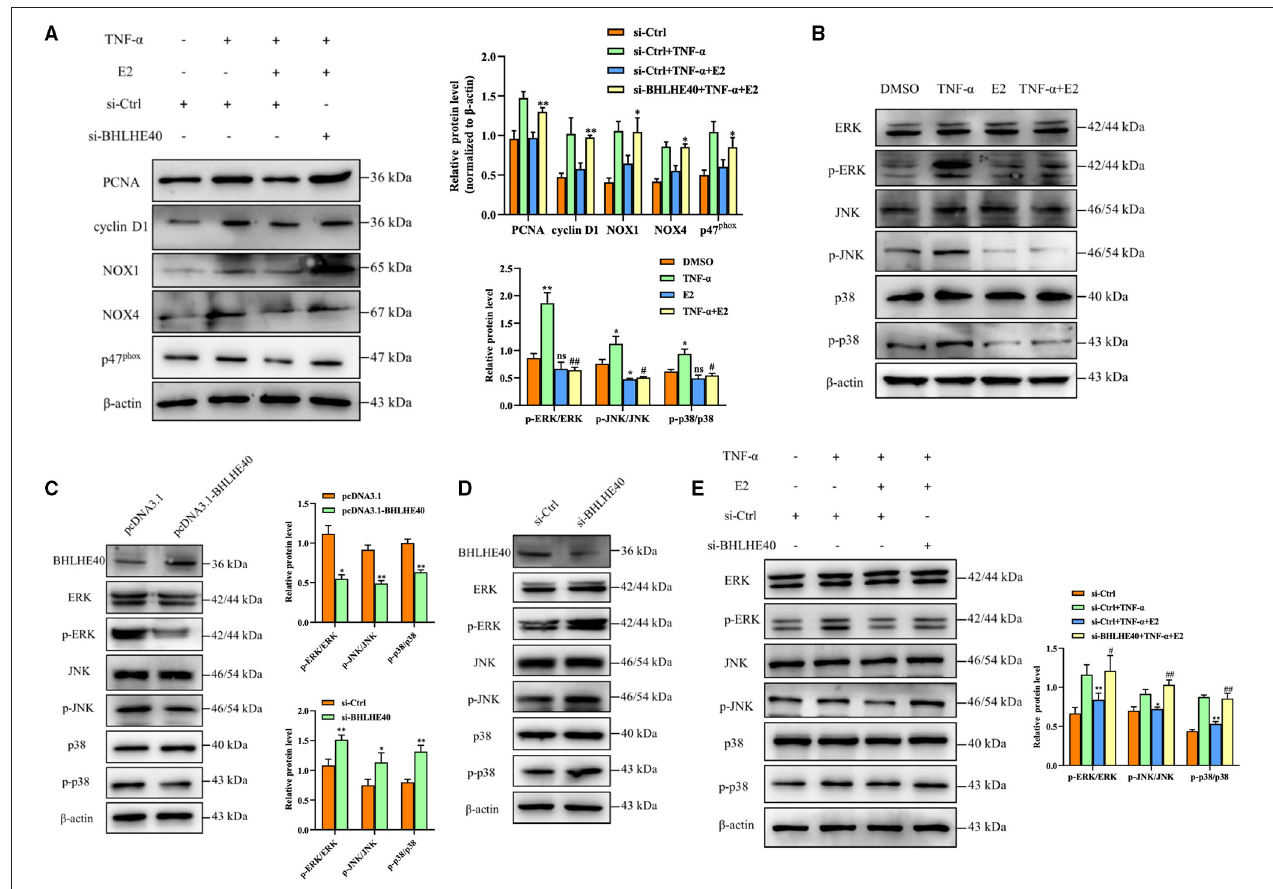
FIGURE 6 | BHLHE40 suppresses proliferation and oxidative stress responses through suppressing MAPK signaling pathways. (A) VSMCs were transfected with si-BHLHE40 or si-Ctrl and then treated with the indicated treatments. The expression of PCNA, cyclin D1, NOX1, NOX4 and p47 phox was determined by Western blotting. Statistic of band intensities is shown on the right. * p < 0.05 and ** p < 0.01 vs. si-Ctrl + TNF- α + E2 group. (B) VSMCs were pretreated with E2 (100nM) for 6h and then were stimulated with TNF- α (10ng/mL) for 24h. Western blotting was performed for total and phosphorylated ERK, JNK and p38. Statistic of band intensities is shown on the left. * p < 0.05 and ** p < 0.01 vs. DMSO group, # p < 0.05 and ## p < 0.01 vs. TNF- α group. (C) VSMCs were transfected with pcDNA3.1- BHLHE40 for 24h, and Western blotting analysis was performed for total and phosphorylated ERK1/2, JNK and p38. Statistic of band intensities is shown on the right. * p < 0.05 and ** p < 0.01 vs. pcDNA3.1 group. (D) VSMCs were transfected with si-BHLHE40 for 24h, and Western blotting analysis was performed for total and phosphorylated ERK, JNK and p38. Statistic of band intensities is shown on the left. * p < 0.05 and ** p < 0.01 vs. si-Ctrl group. (E) VSMCs were transfected with si-BHLHE40 or si-Ctrl and then treated with the indicated treatments. Total protein lysates were collected and the expression of ERK, JNK and p38 and their phosphorylated forms were examined by Western blotting. Statistic of band intensities is shown on the right. * p < 0.05 and ** p < 0.01 vs. si-Ctrl + TNF- α , # p < 0.05 and ## p < 0.01 vs. si-Ctrl + TNF- α + E2